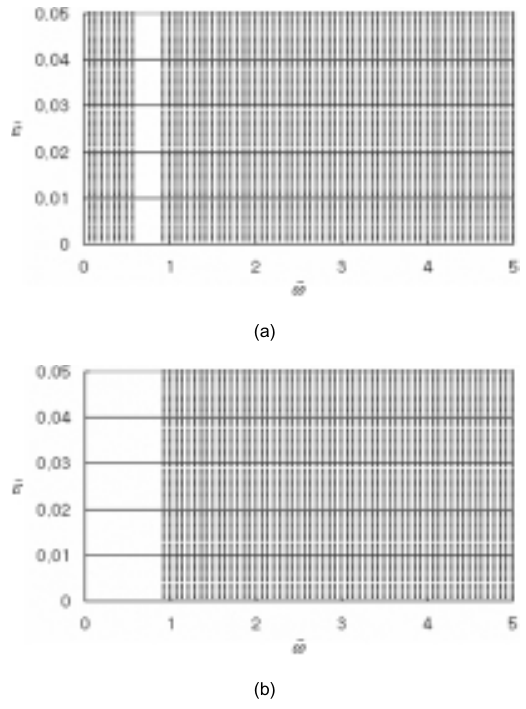
Fig. 6. Comparison of stability for the variation of ˜ ω and ˜ ε . (a) Pendulum Automatic Dynamic Balancer. (b) Ball Automatic Dynamic Balancer.